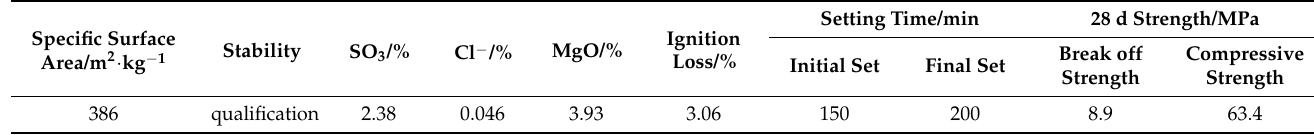
Table 1. Main technical indicators of cement.